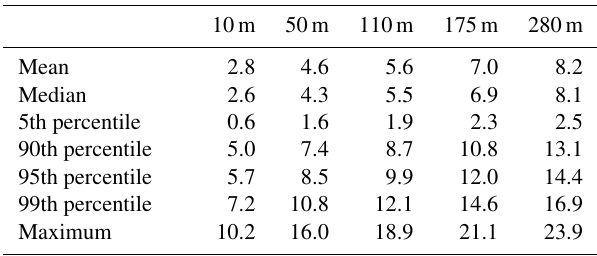
Table A1. Statistical data on hourly wind speed values [m s − 1 ] from the Hamburg weather mast for the year 2018.